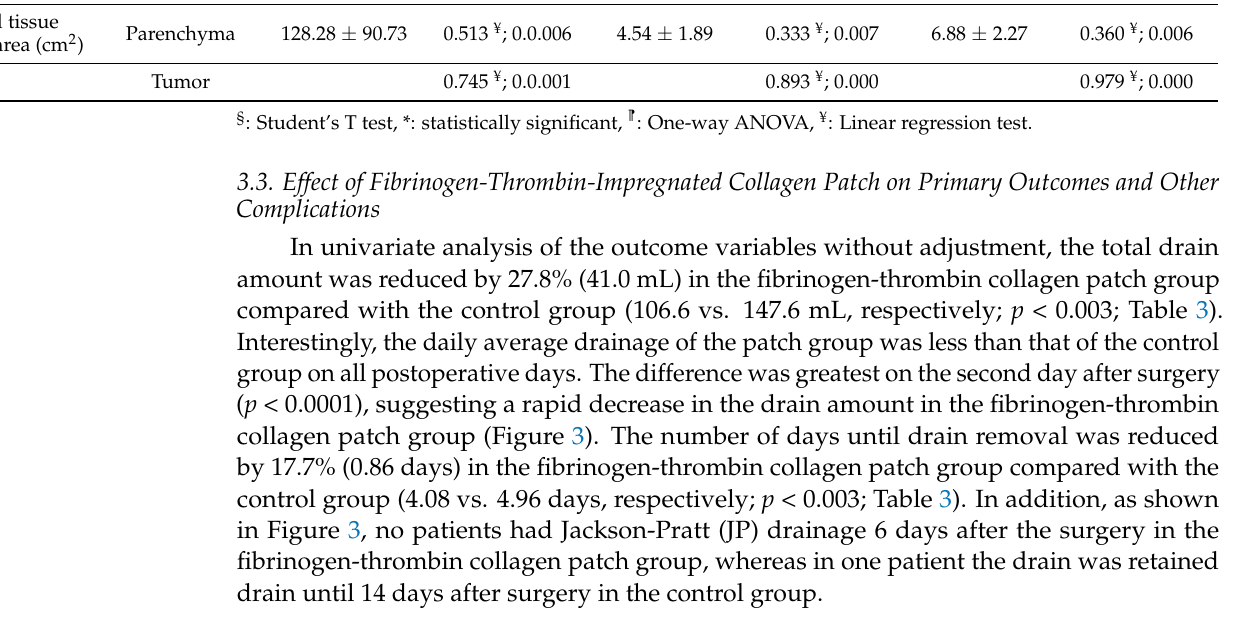
Table 2. Associations between baseline characteristics and primary outcome variables.